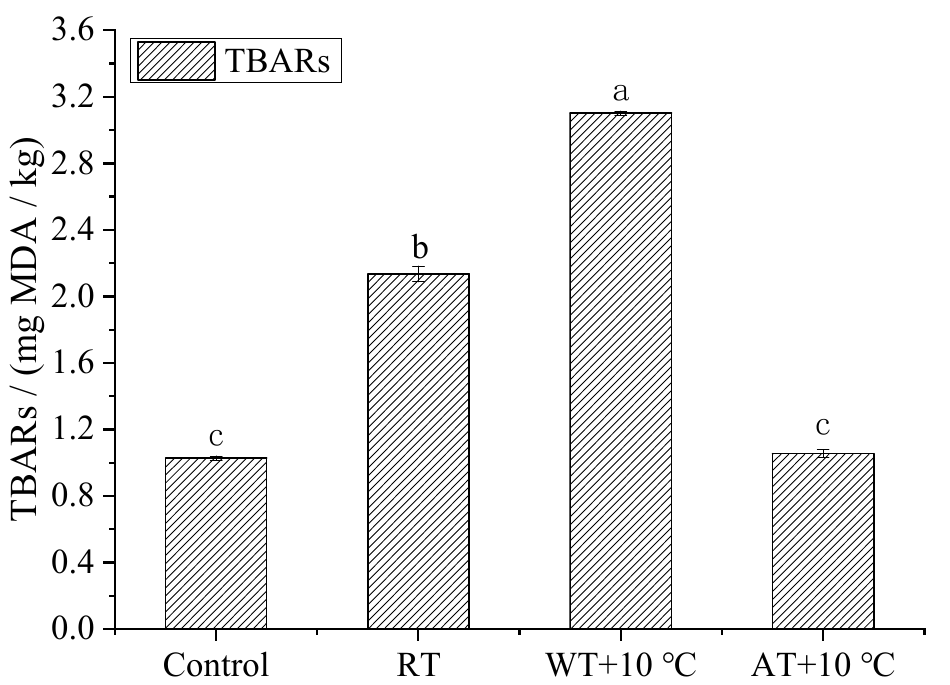
Figure 5. Effects of different tempering methods on TBARS of salmon. (RT: Radio frequency tem- pering; WT + 10 ◦ C: Water tempering at 10 ± 0.5 ◦ C; AT + 10 ◦ C: Air tempering at 10 ± 1 ◦ C). Different letters on the bar (a,b,c) indicate significant differences ( p < 0.05) among samples treated with different methods.